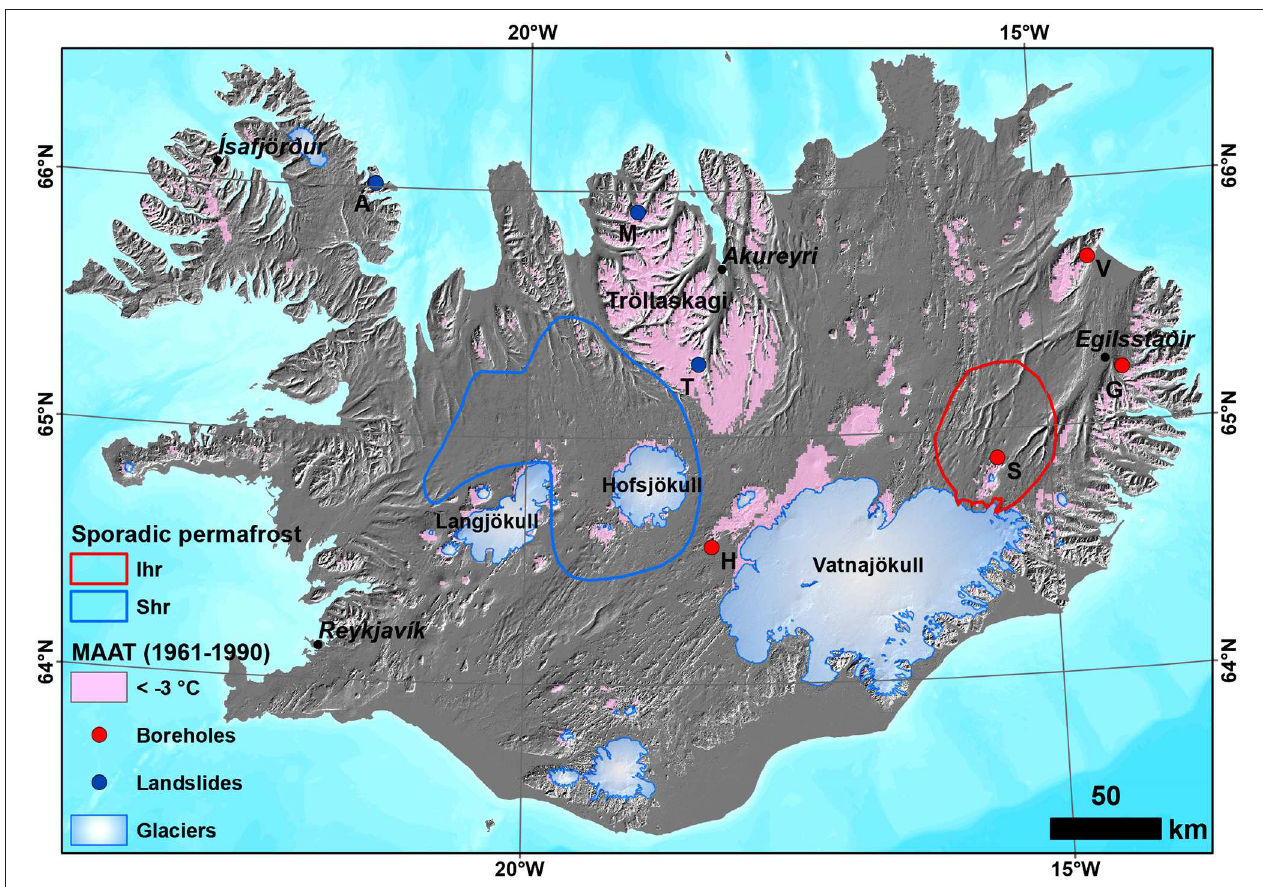
FIGURE 1 | Sporadic permafrost from Brown et al. (1997): Ihr, Isolated patches of permafrost extent with high ground ice content and thin overburden and exposed bedrock; Shr, Sporadic permafrost extent with high ground ice content and thin overburden and exposed bedrock. MAAT < − 3 ◦ C indicates areas of widespread permafrost as modelled in Etzelmüller et al. (2007). Boreholes: G, Gagnheiði; H, Hágöngur; S, Sauðafell; V, Vopnafjörður. Landslides with ice-cemented deposits: M, Móafellshyrna Mountain; T, Torfufell Mountain; Á, Árnesfjall Mountain. Map data from the National Land Survey of Iceland (NLSI; License: http://www.lmi.is/wp- content/uploads/2013/10/licenceNLSI.pdf).